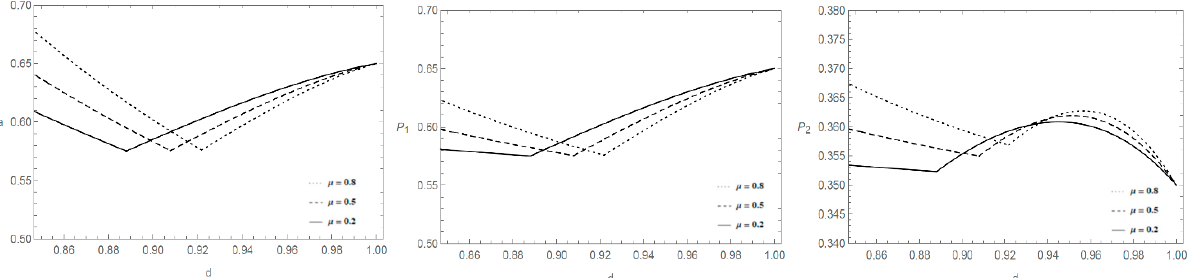
Figure 4. Comparison of Cover and Retail Prices (close-up when d is in the high range). ( a is the cover price of printed book; P 1 is the retail price of printed book; P 2 is the retail price of e-book; d is the publisher’s wholesale discount rate of the printed book; μ is the degree of consumers’ concern about a discount.).